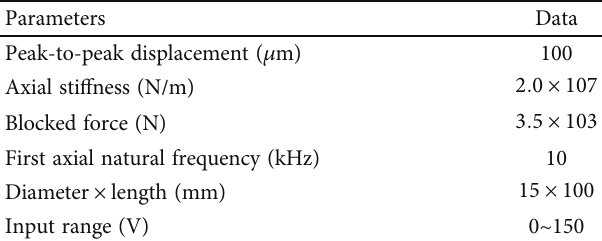
Figure 9: Actuation system mounted on the elastic beam. Table 3: Parameters of the piezoelectric Table 4: Parameters of the beam structure.